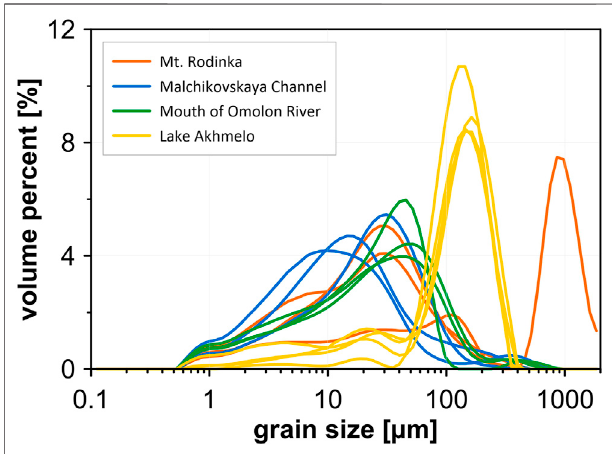
FIGURE 5 | Grain size distribution of the active layer